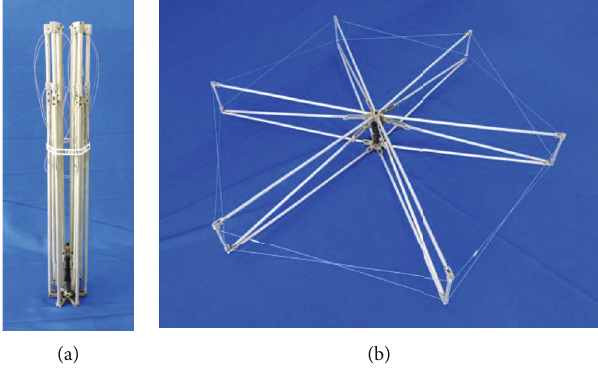
Figure 7: Prototypes of single module. (a) Stowed. (b)